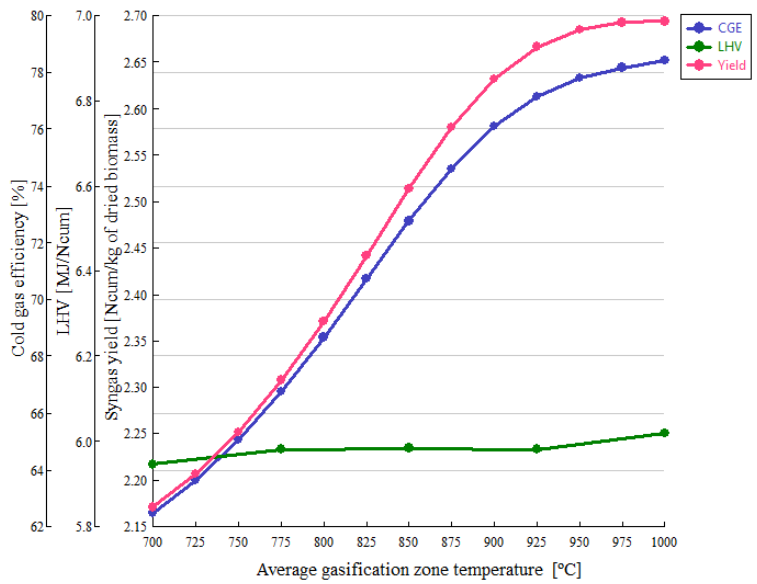
Figure 5. Cold gas efficiency, LHV, and syngas yield as a function of gasification temperature.